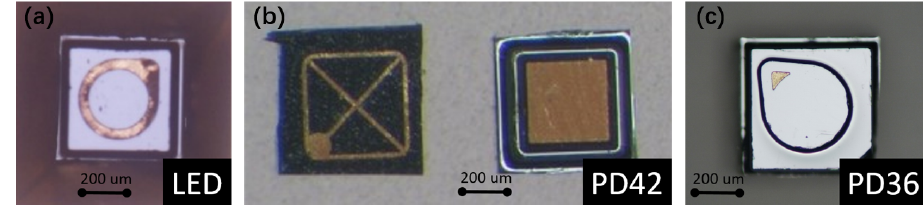
Figure 3. Microscope images of the ( a ) LED, ( b ) PD42 and ( c ) PD36 bare chips. PD42 and PD36 are the photodiodes used in the sensing and reference channels, respectively.